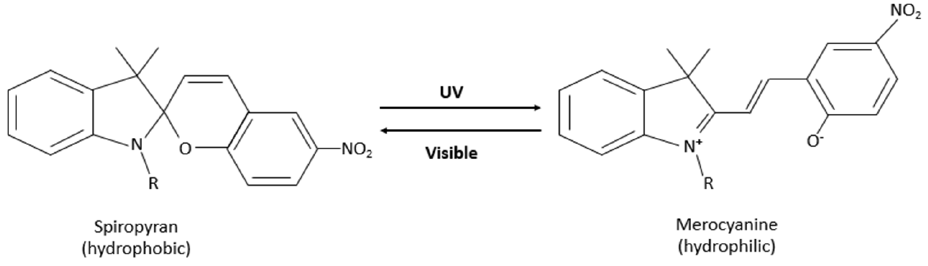
Figure 3. Photo-isomerization of Spiropyran and Merocyanine. Figure 3. Photo ‐ isomerization of Spiropyran and Merocyanine.